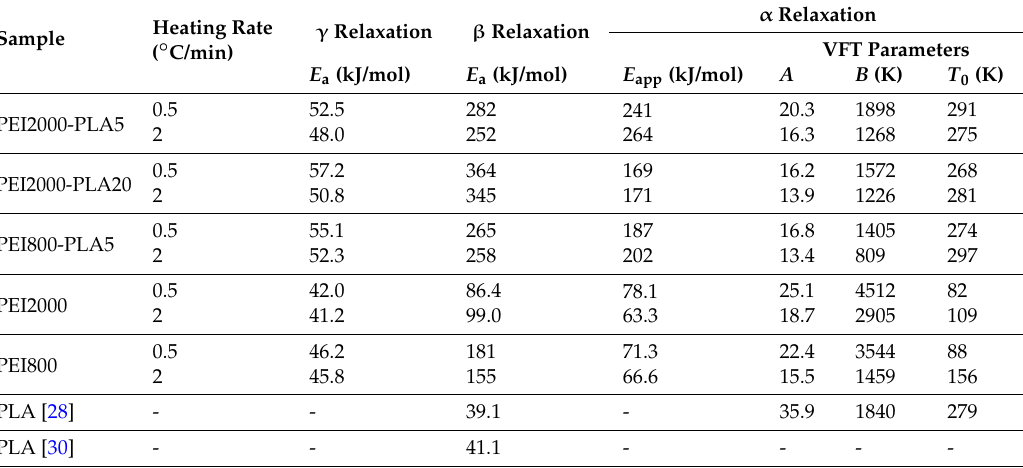
Table 3. Activation energy values E a and Vogel–Fulcher–Tammann (VFT) parameters for the different samples studied.